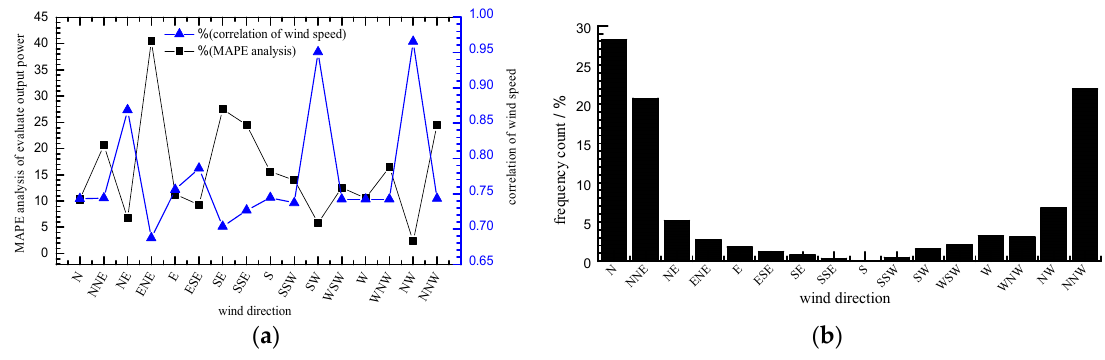
Figure 14. Equivalent error distribution in different wind direction zones; ( a ) Equivalent error in different wind direction zones; ( b ) Wind speed ‐ frequency histogram.